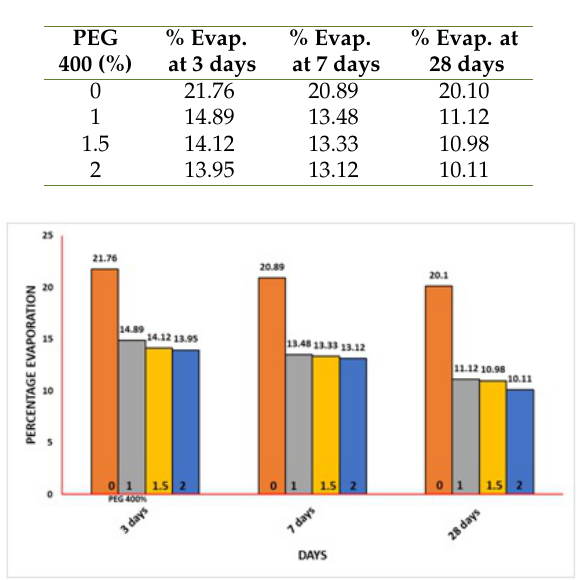
Table 2. Percentage Evaporation at 0.55 Water-Cement Ratio.